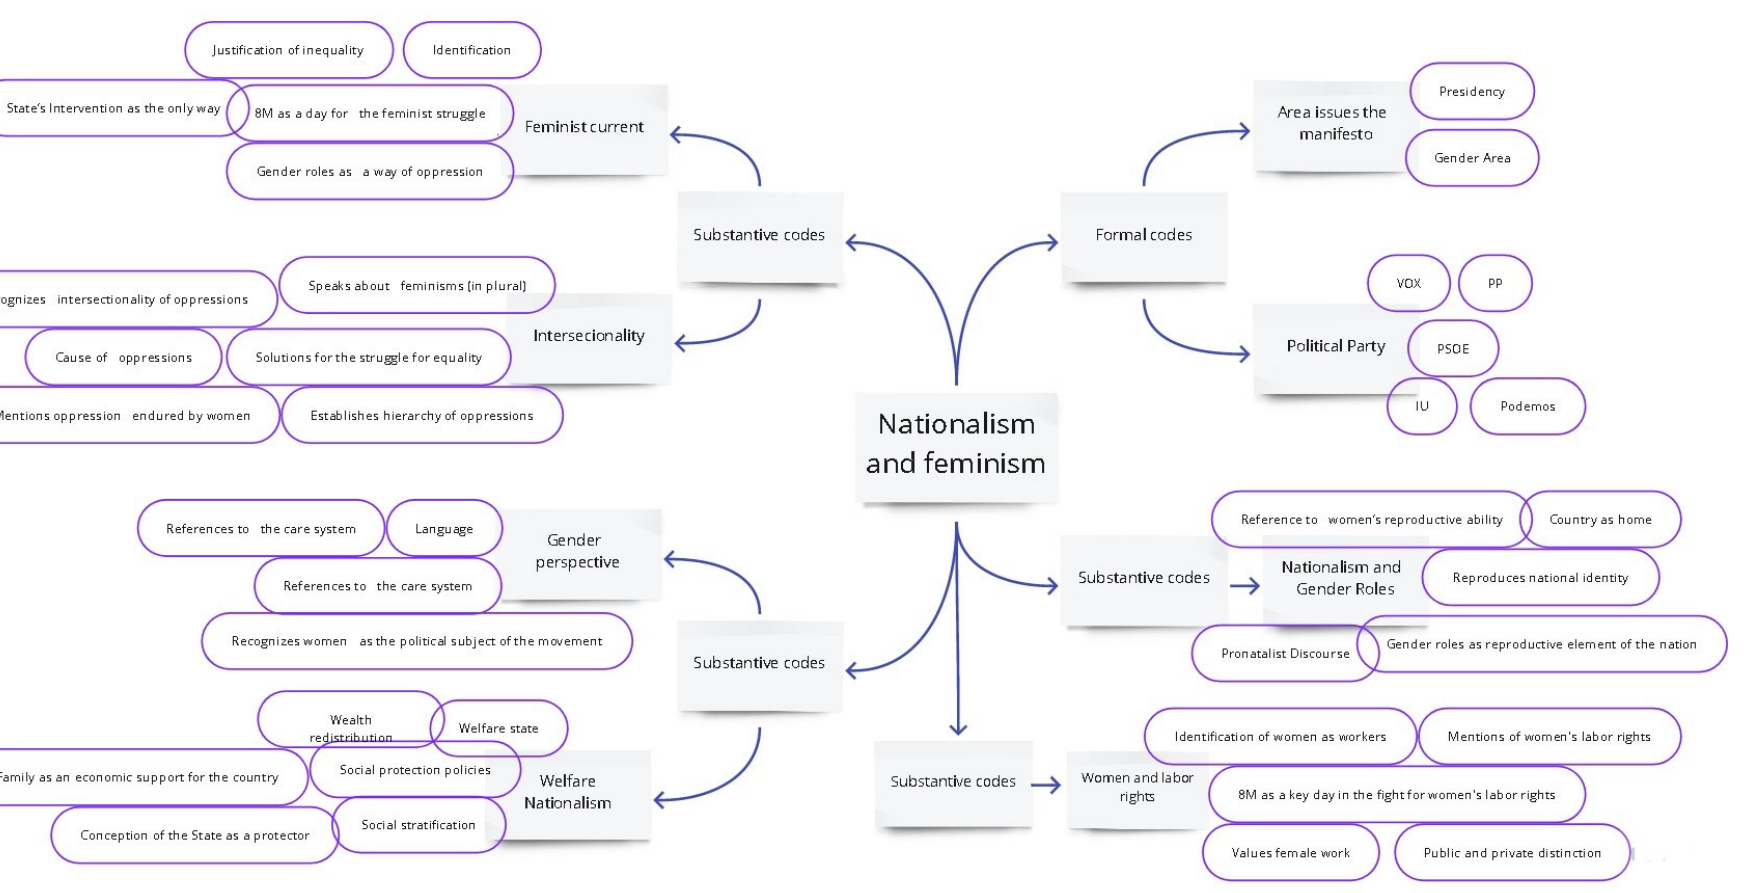
Figure 1. Dimensions and indicators for the measurement of nationalism and feminism in the 8M manifestos. Source: The authors’ own elaboration from the adaptation of the coding protocol developed by Humlebaek and Ruiz (2018).